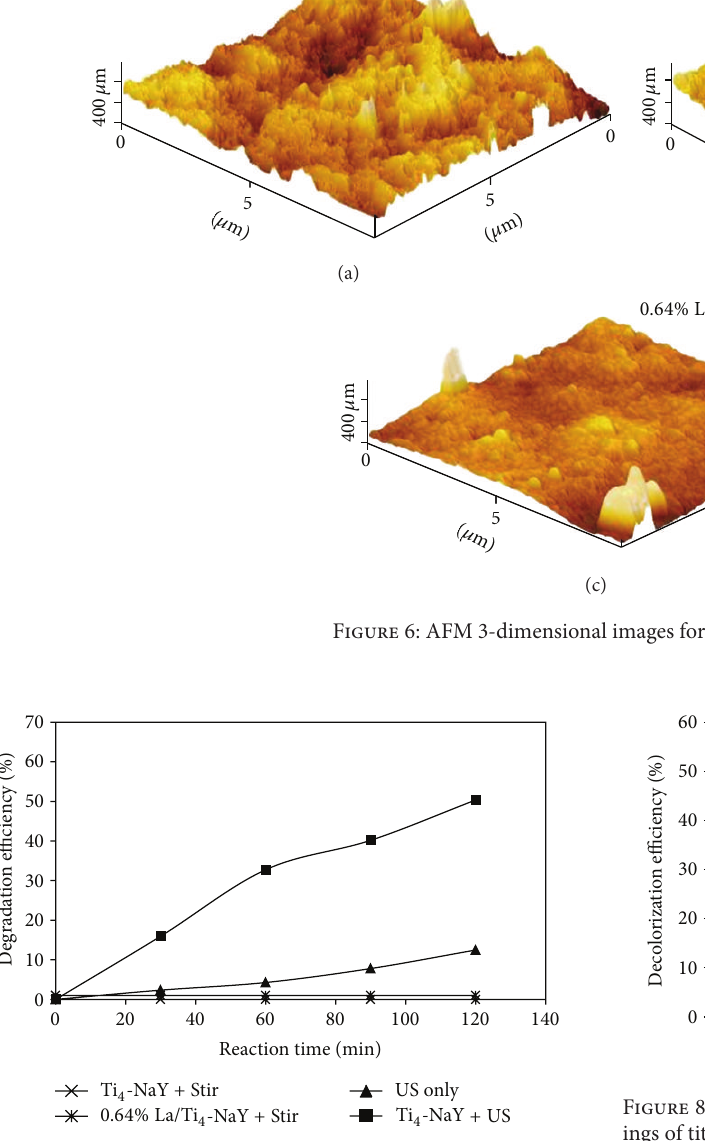
Figure 7: Preliminary study of the catalysts with and without ultrasonic irradiation (10mg/L initial dye solution, 1.5 g/L catalyst loading, original pH, and 120 min of reaction).